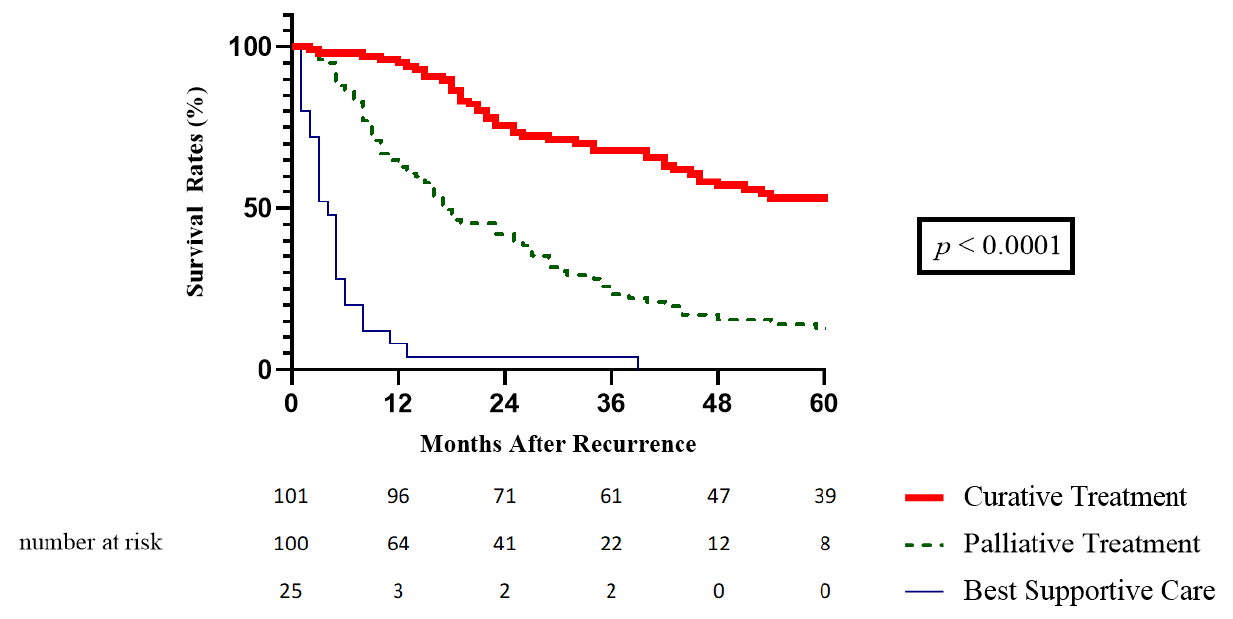
Figure 2. Survival after recurrence according to treatment of